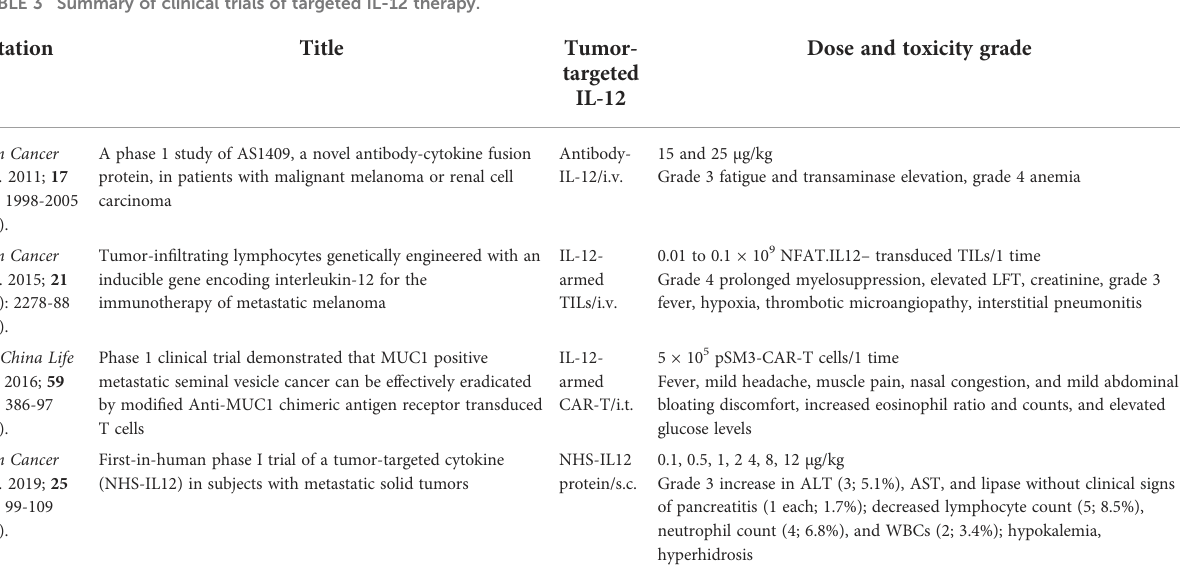
TABLE 3 Summary of clinical trials of targeted IL-12